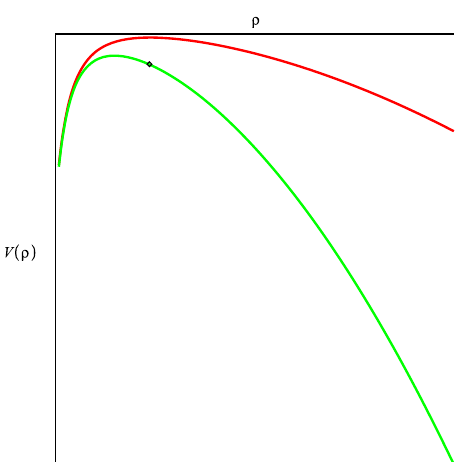
Figure 2. The potential in the Ermakov-Pinney analog potential problem for abrupt quench fopr ! 0 < ! 1 . The red curve is the potential for (cid:28) < 0, while the green curve is the potential for (cid:28) > 0. The black dot is the position of the analog particle at (cid:28) = 0.